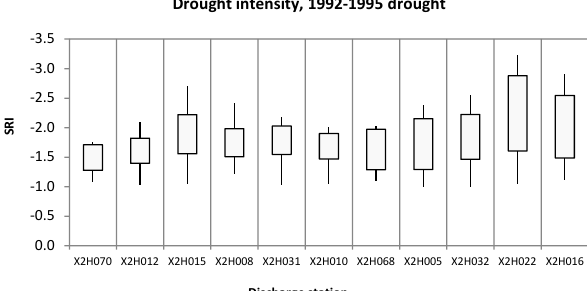
Figure 8. Hydrological drought intensity during the 1992–1995